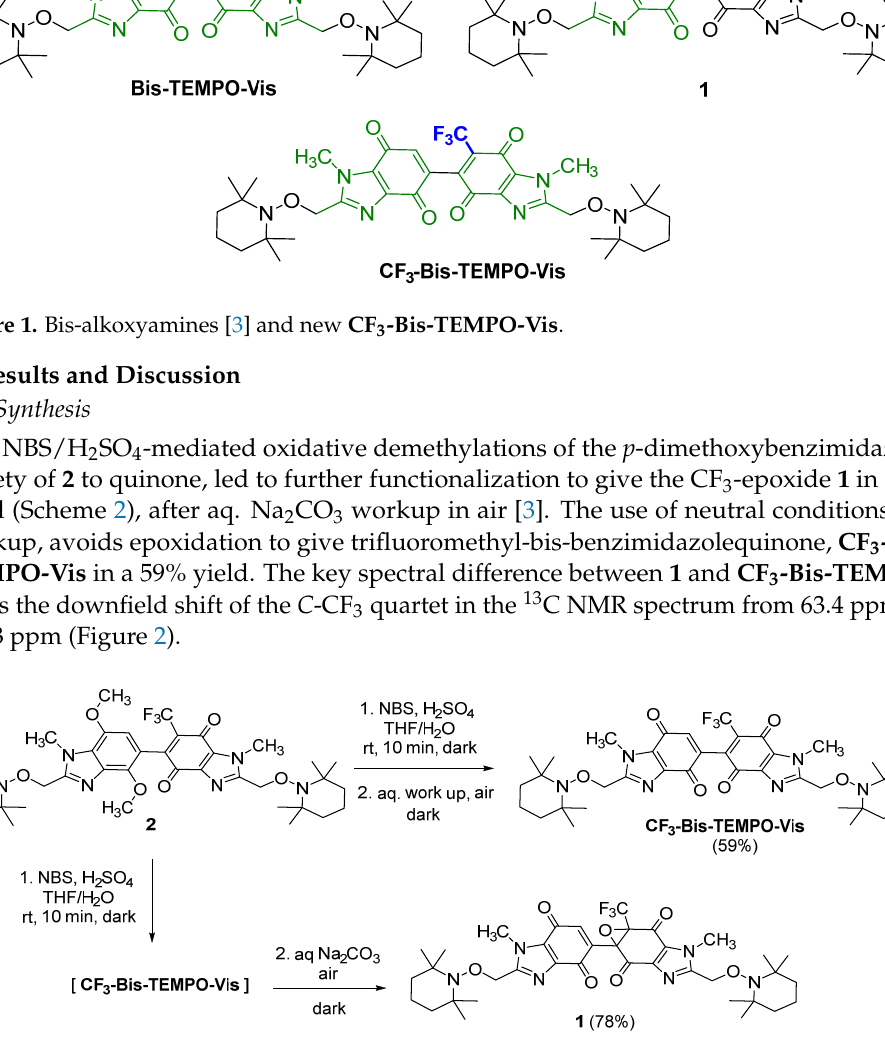
3 -Bis-TEMPO-Vis .